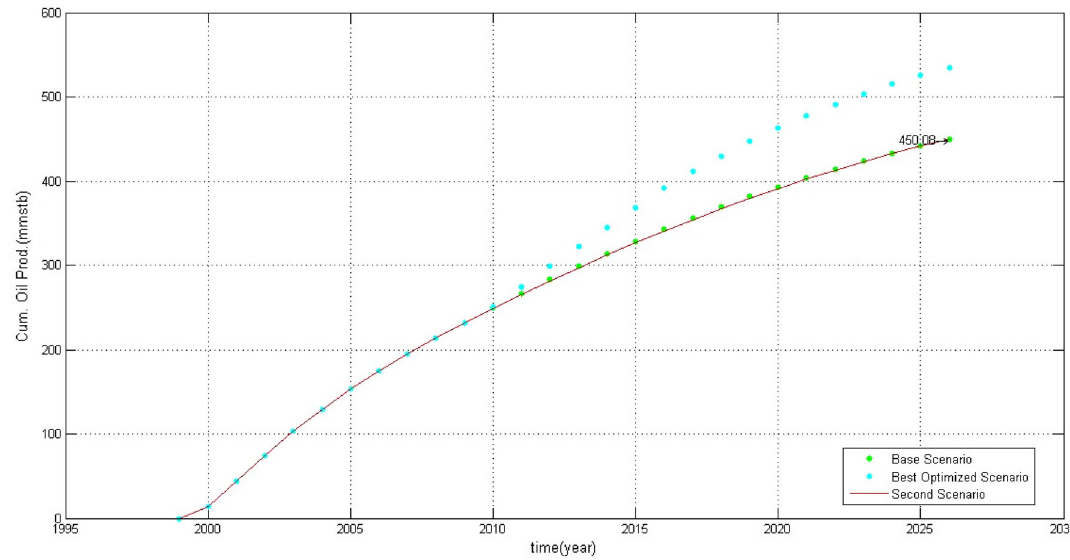
Fig. 4 Cumulative oil production of second scenario